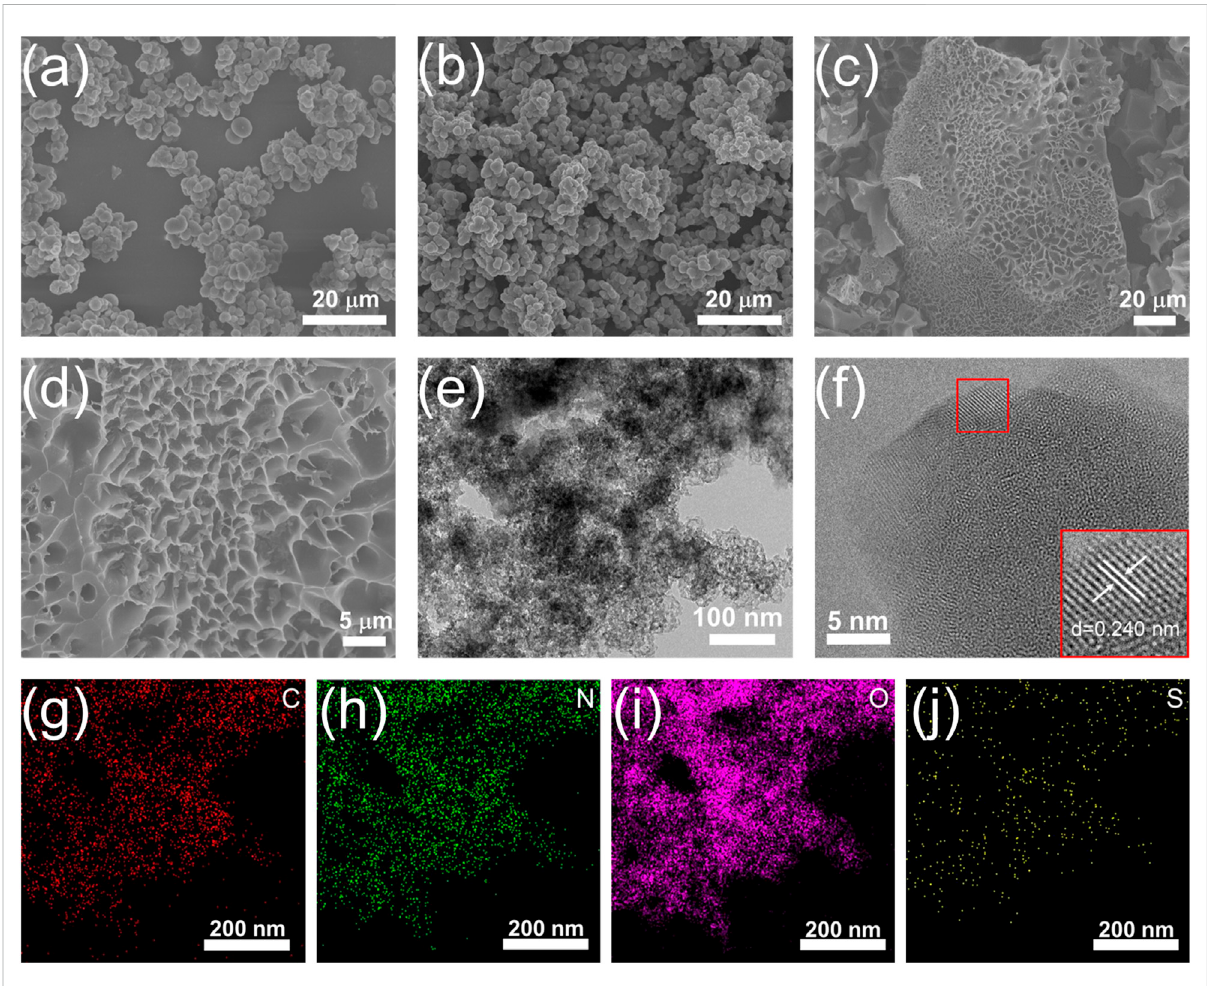
FIGURE 2 SEM imagesof (A) NSPR and (B) NSC (C,D) SEM images, (E) TEM images, (F) HRTEMimage, and (G – J) EDX elemental mapping imagesof NSPC.